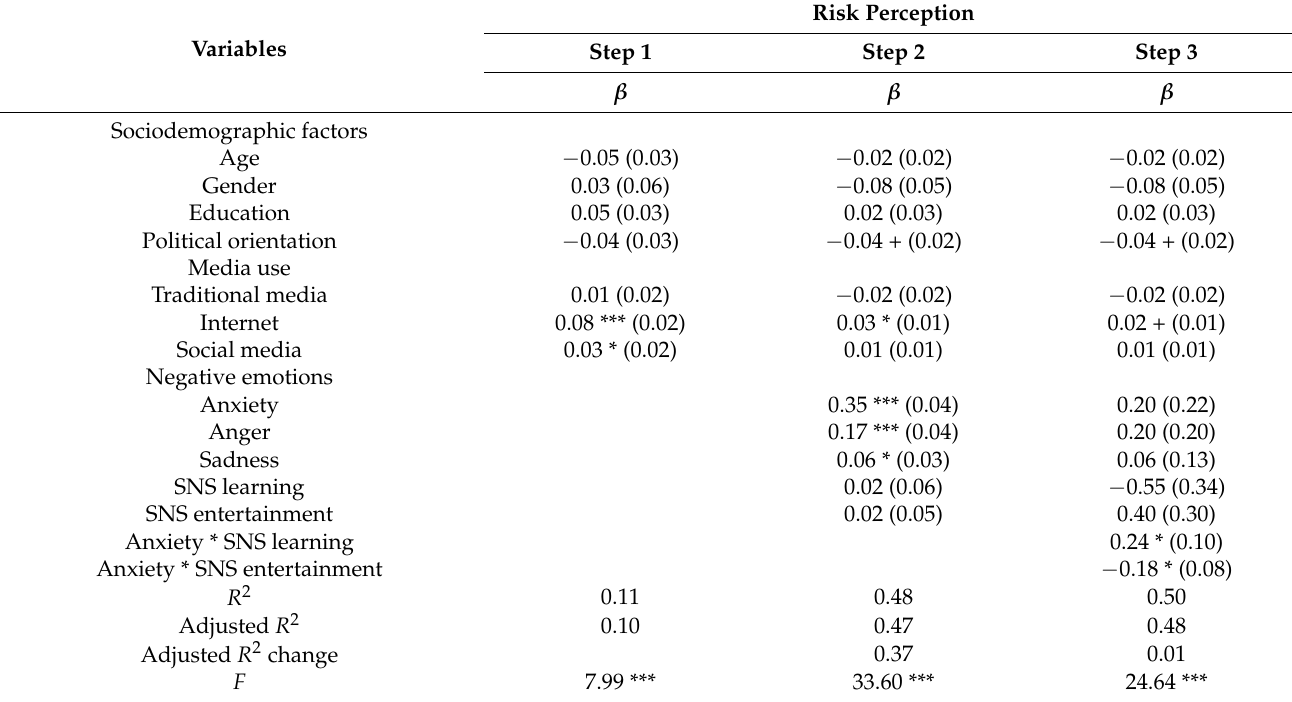
Table 3. Hierarchical regression analyses predicting risk